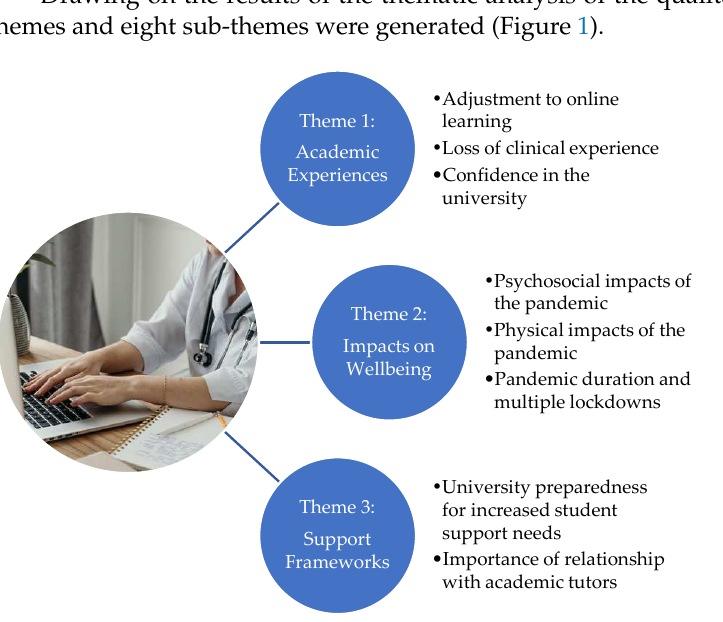
Figure 1. Summary of themes and sub-themes .